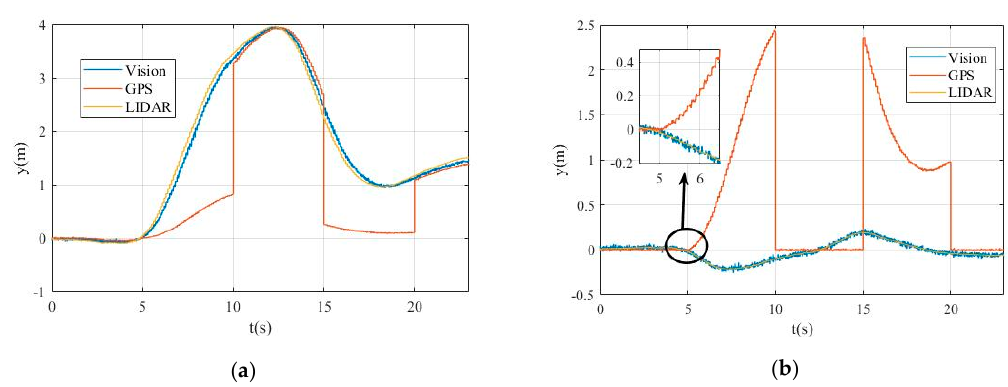
Figure 14. The lateral position changes in experiment: ( a ) lateral position detected by using different sensors; and ( b ) the lateral position error.